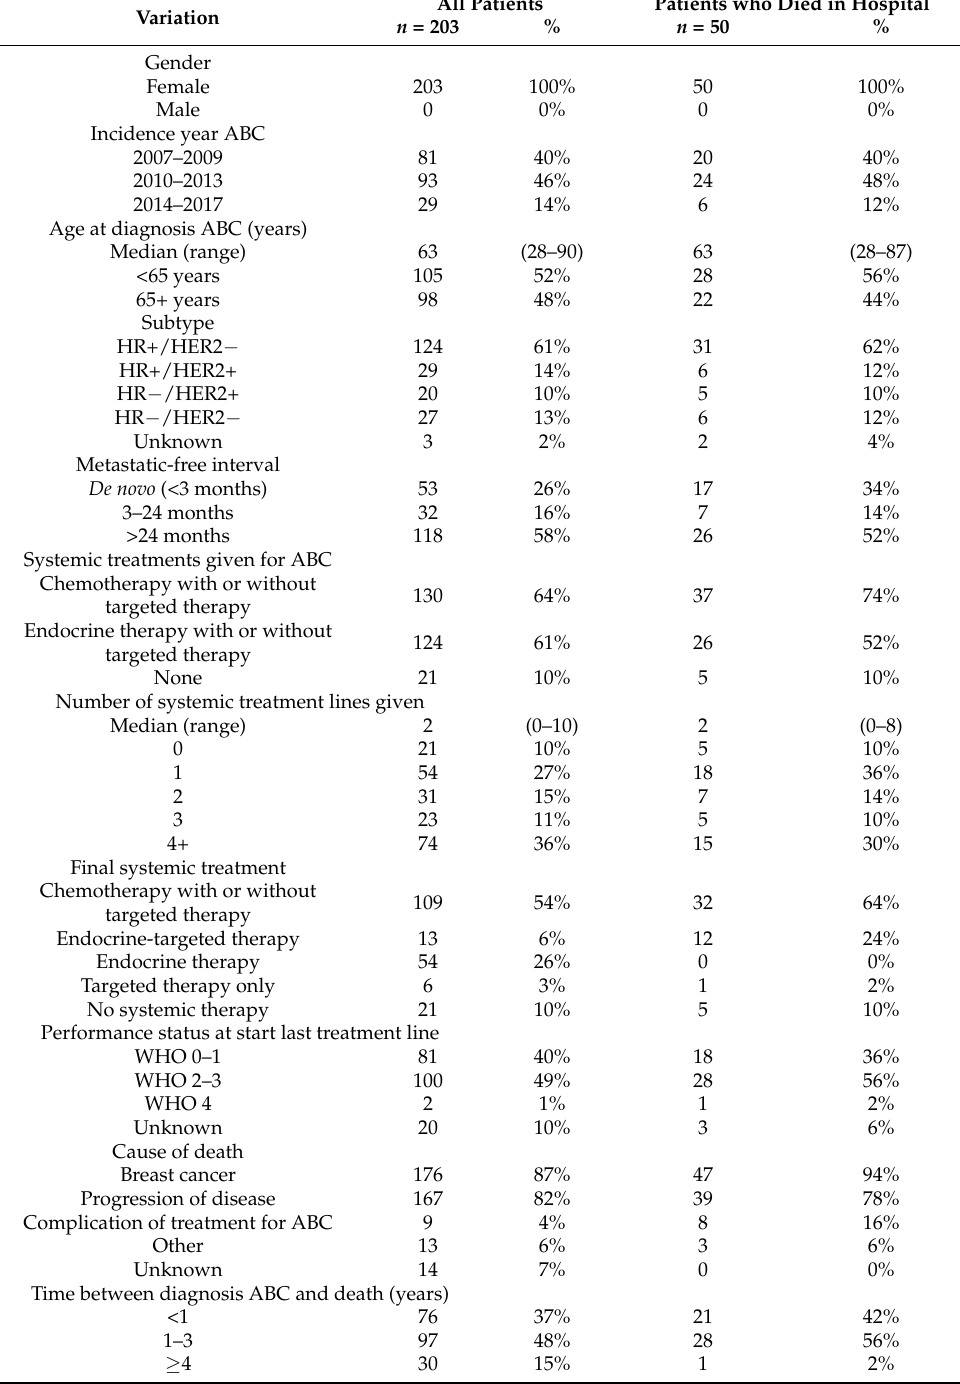
Table 1. Patient, disease and treatment characteristics of all patients who died after being diagnosed with advanced breast cancer (left column) and of the 50 patients who died in the hospital (right